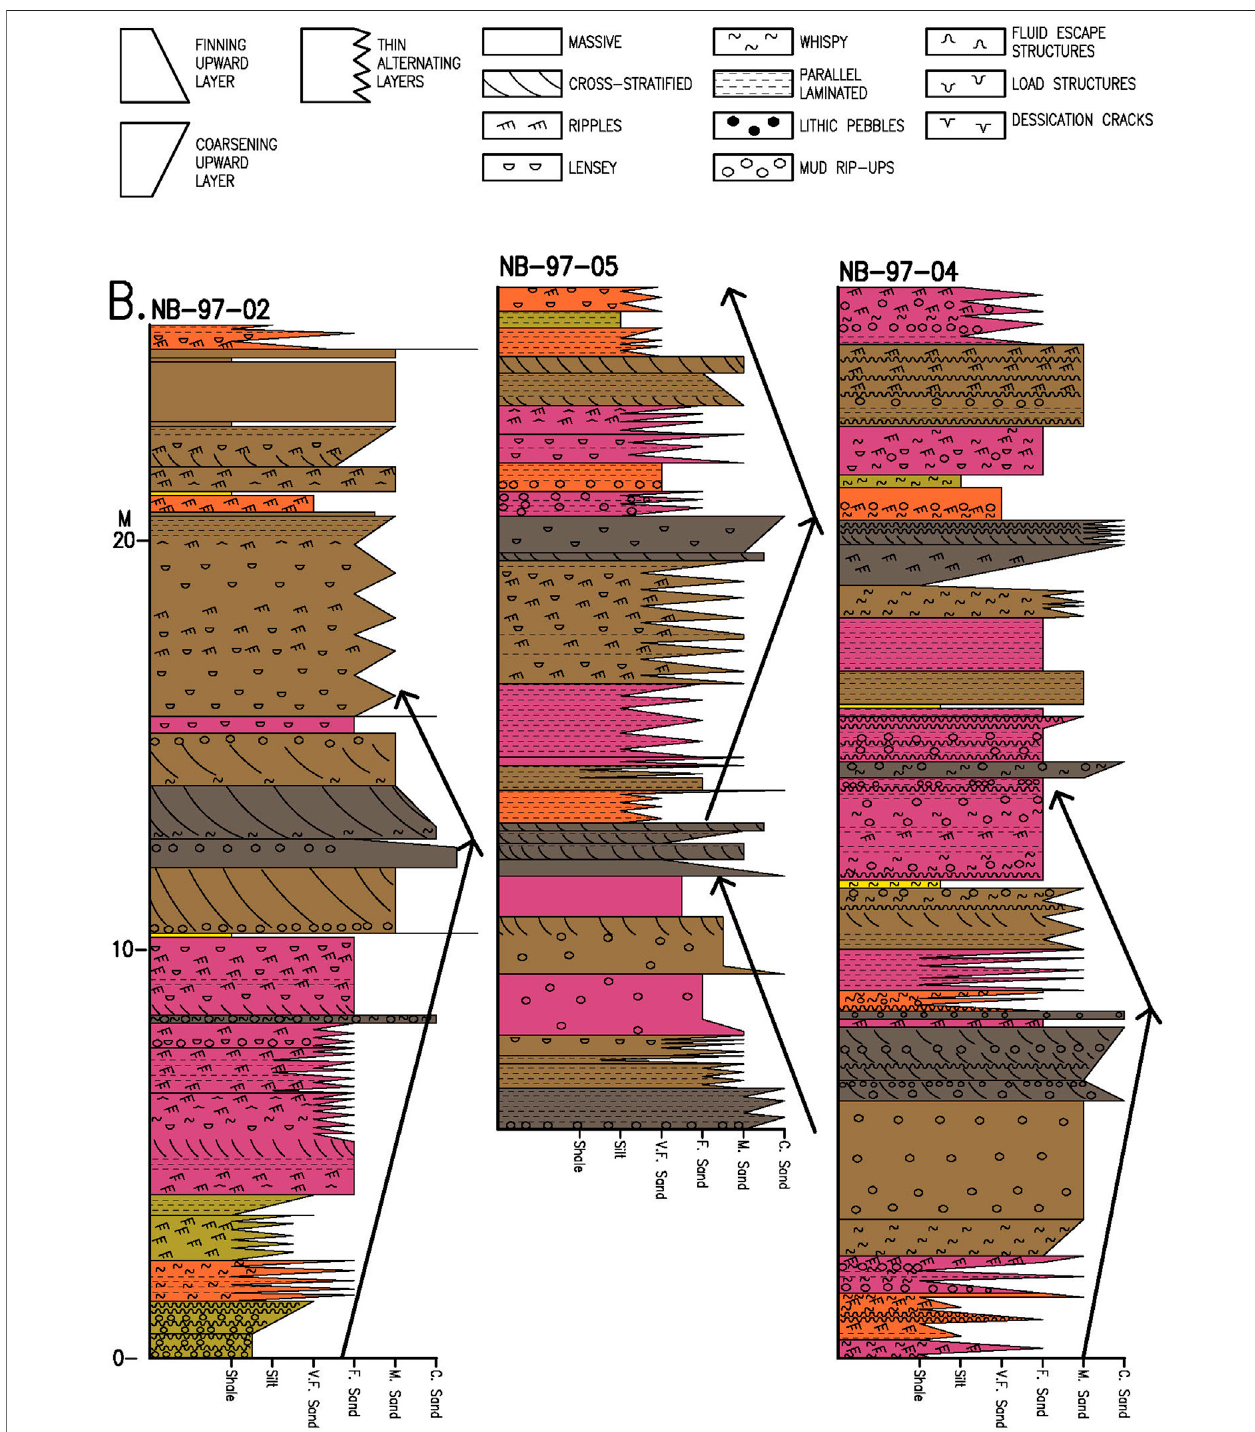
FIGURE 6 | Strata forming the top of the lower coarsening- and thickening-upward succession. The lower coarsening-upward parasequences in NB-97-02 and NB-97-04areoverlainby fi ningupwardparasequences.Thismayre fl ectthetopofthedistributary-mouthbaroverlainbychanneldeposits.HoleNB-97-05endedbefore penetrating the coarsening-upward parasequence, but it contains the fi ning-upward parasequence that overlies it. The upper portion of the strata detailed here is unstructured in NB-97-02 and NB-97-04, but continues to have a progradational and retrogradational parasequence coarsening and fi ning cycles in NB-97-05, possibly re fl ecting this are re fl ooding with reestablishment of a bar top distributary system. Location of detailed sections in B depicted on Figure 2 .